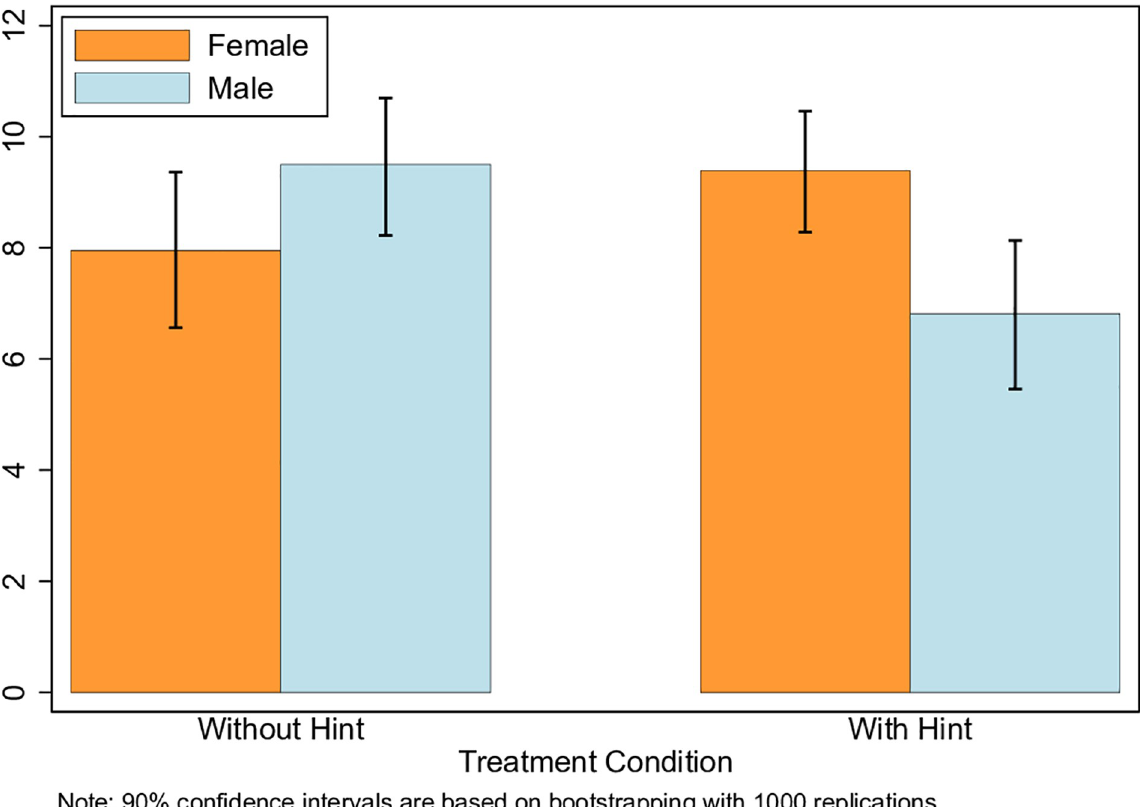
Fig 4. Switching point gender comparison by bootstrap method.